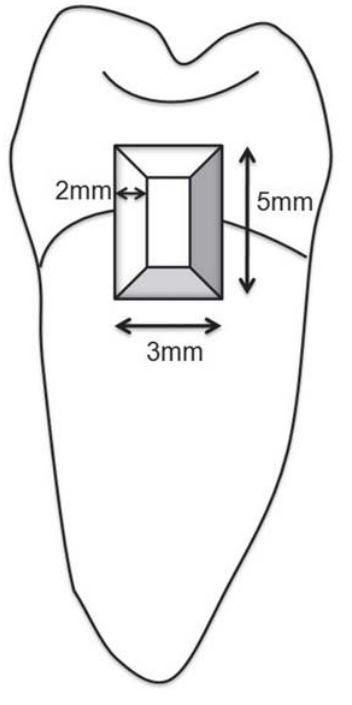
FIGURE 1- Schematic image of the window-like